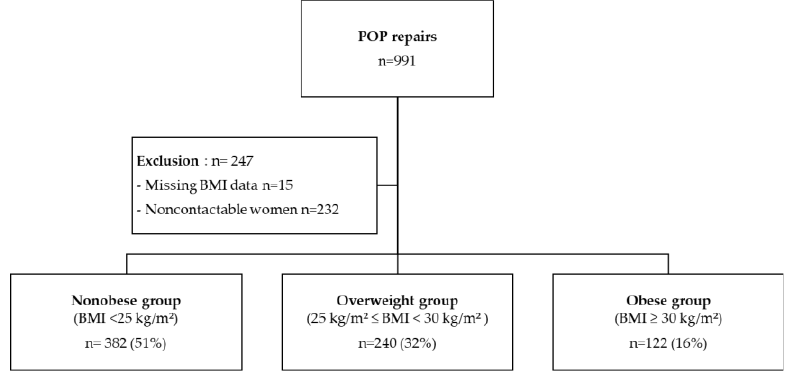
Figure 1. Figure 1. Flowchart.